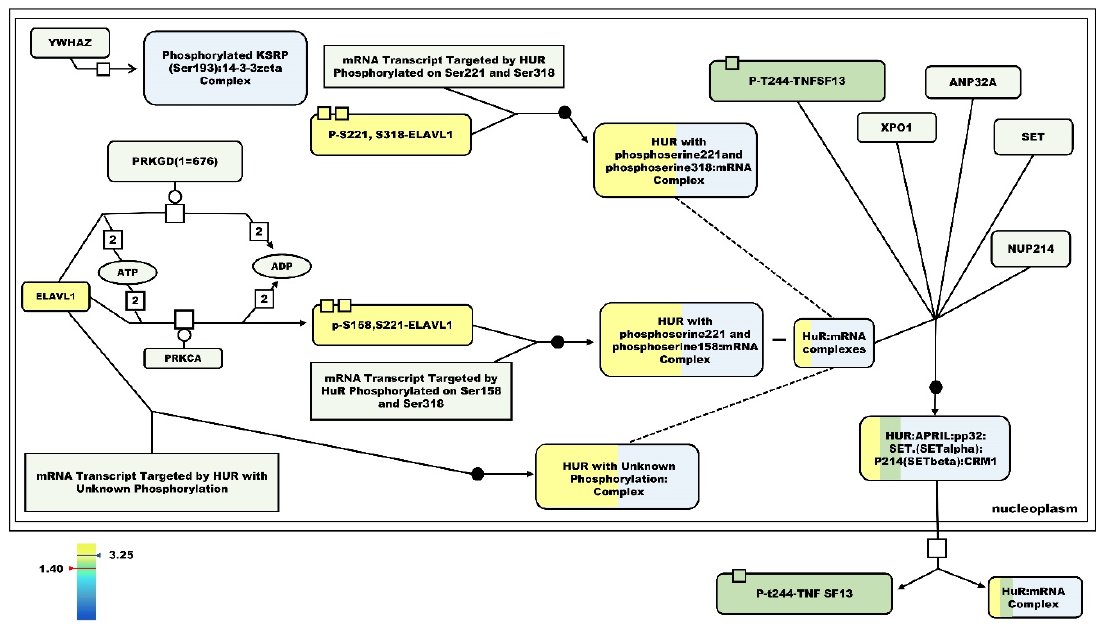
Figure 9. Elav1 pathway for mRNA stabilization. Entities are colored according to the expression scales when the HF / SD group is compared with the HF / RD group. The key elements in the pathway that are upregulated in HF / SL are shaded in yellowish-green tones, according to the expression scale. Yellowish tones indicate positive fold changes and bluish tones refer to negative fold-changes.